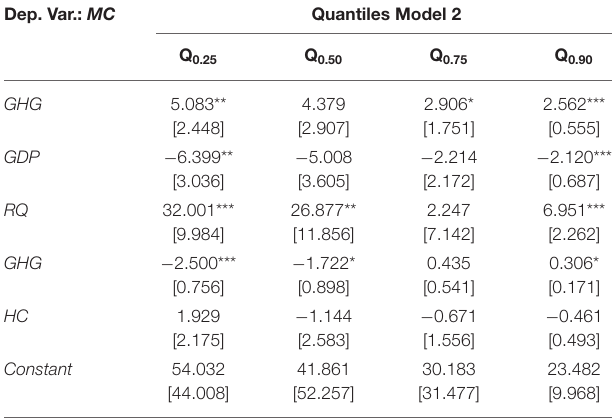
TABLE 8 | Estimates of quantile regression Model 2.